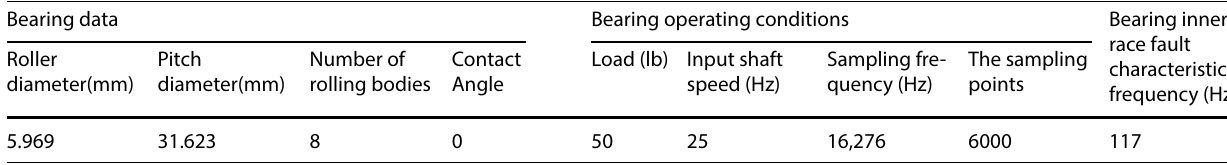
Fig. 7 Iterative curves of CS and GWO search algorithms [20] Table 1 Bearing data and bearing working conditions Bearing data Bearing operating